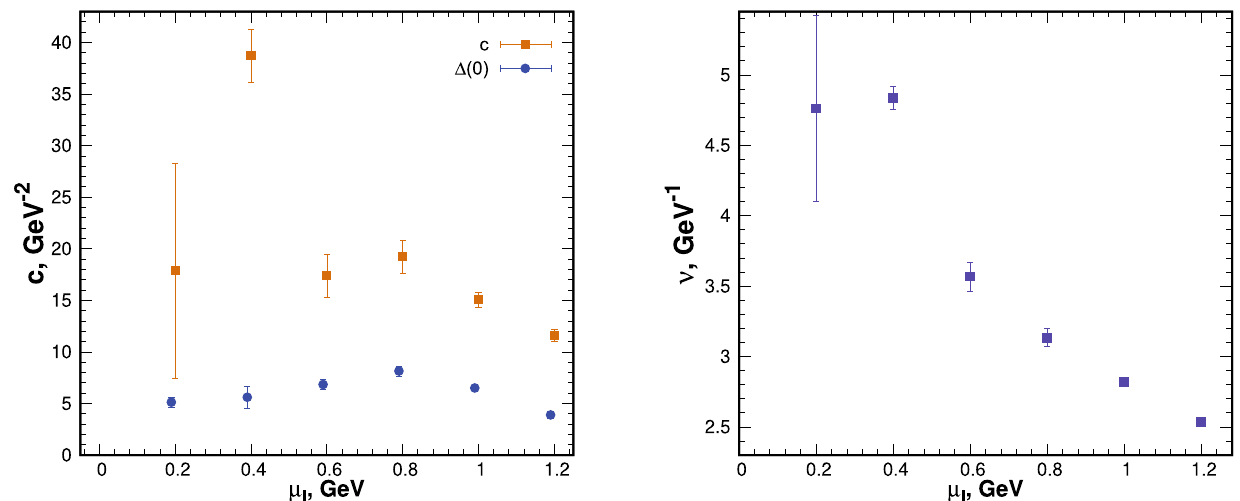
Fig. 9 The parameters of the fit function (27) as functions of μ I . In the left panel the parameter c representing the value of (cid:12)( 0 ) extrapolated by formula (27) from the fit domain is compared with its actual